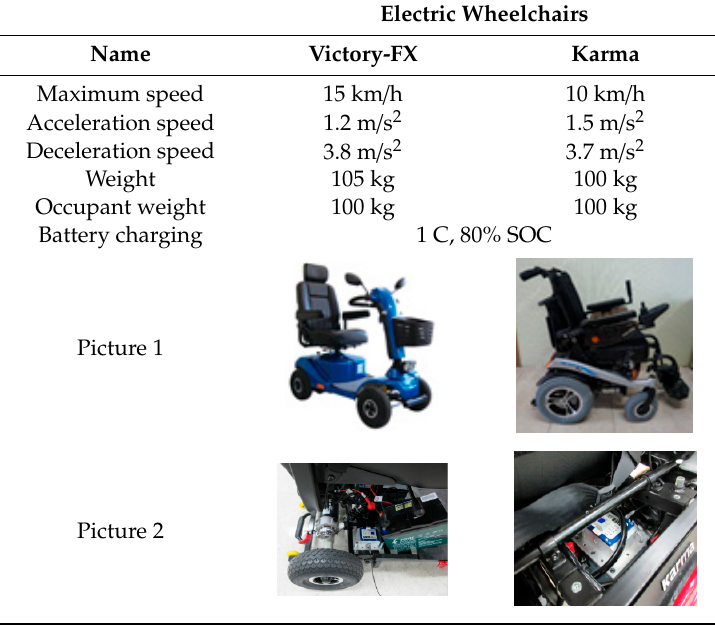
Table 2. Test environment.